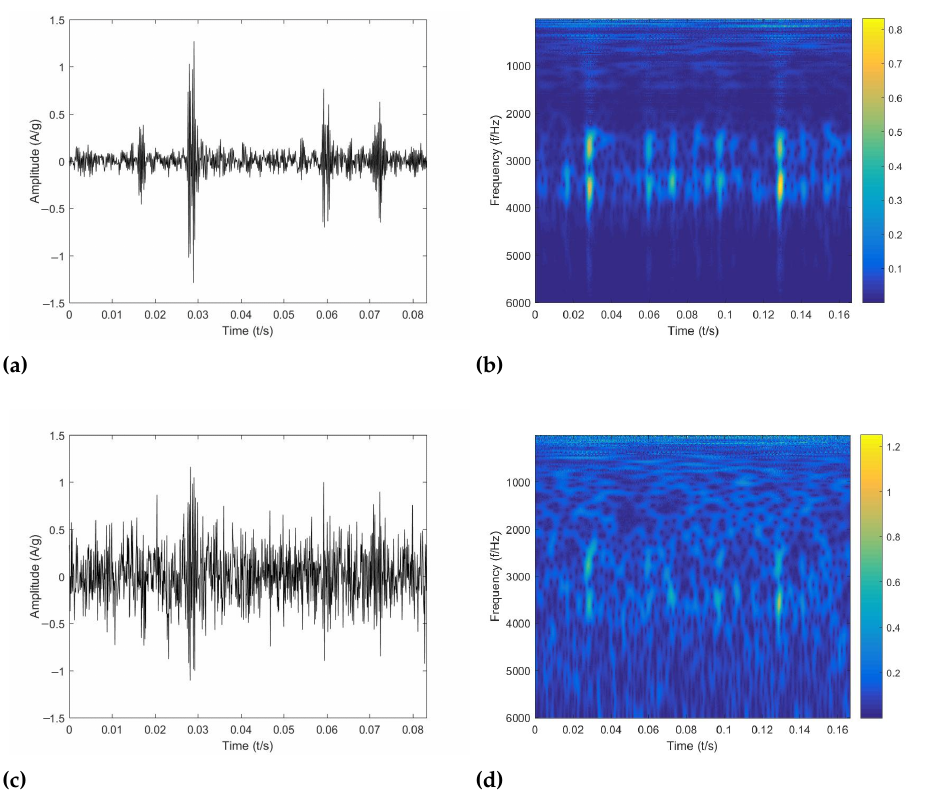
Figure 5. The analyzed results with CWT. ( a ) Vibration signal of inner race fault. ( b ) TFR of inner race fault. ( c ) Vibration signal of inner race fault with additive noise. ( d ) TFR of inner race fault with additive